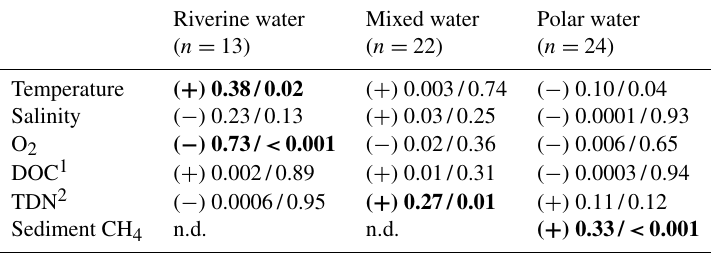
Table 2. Linear correlation between the methane concentration vs. different environmental parameters separated for the three water masses. Analysis was performed with log-transformed data; the r 2 values, the level of significance ( p ), and the positive or negative correlation ( + / − ) are shown. Bold numbers indicate a significant correlation ( p < 0 .